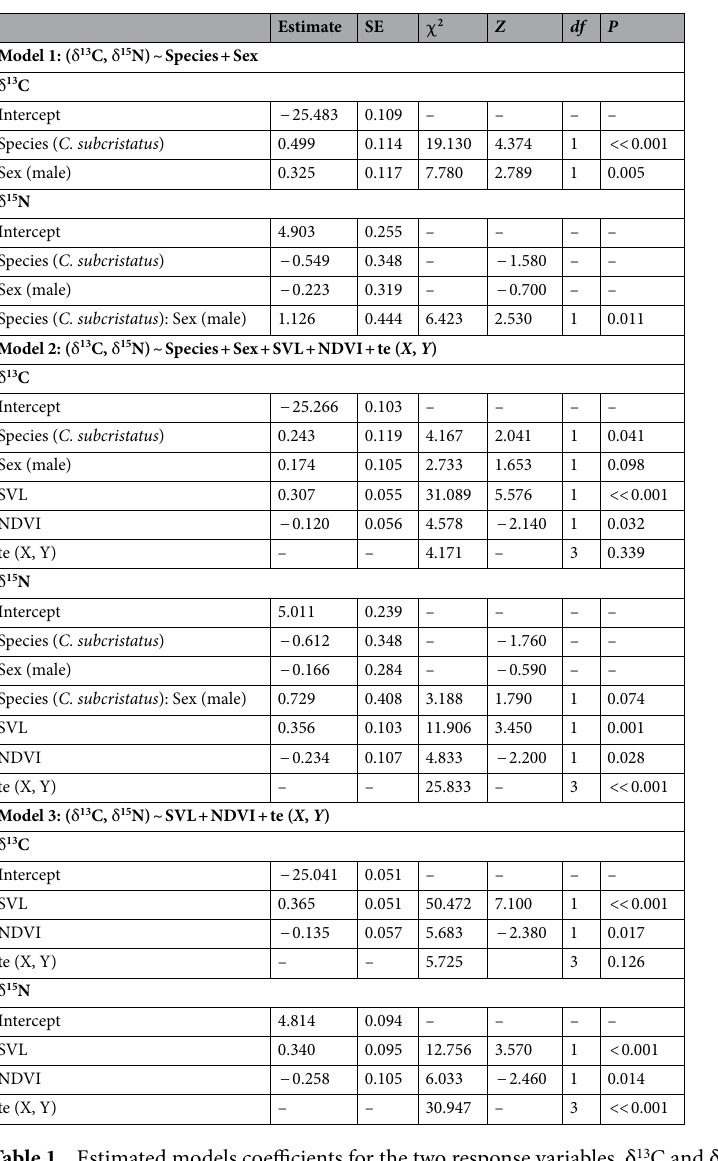
capture point and the spatial tensor product smooth as predictors. The table reports the estimated model value (Estimate), standard error (SE), degrees of freedom ( df ), the χ 2 statistic for LRT with the corresponding P -values ( P) and the z -score ( z ). The interaction between Species and Sex was not a significant predictor of δ 13 C ( χ 2 = 0.386, P = 0.535) and was therefore removed from the final models. P -values for intercept and for main effects included in an interaction do not have a meaningful interpretation and are not